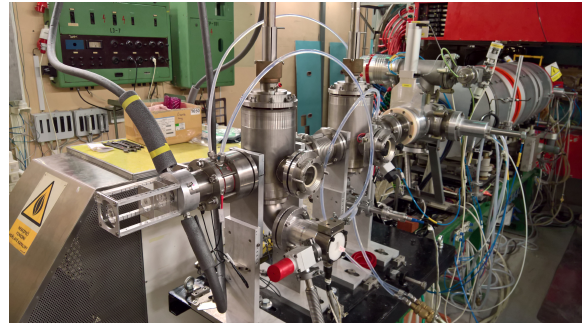
Figure 3. The beryllium target station NG-2 at the Nuclear Physics Institute of The Czech Academy of Sciences.